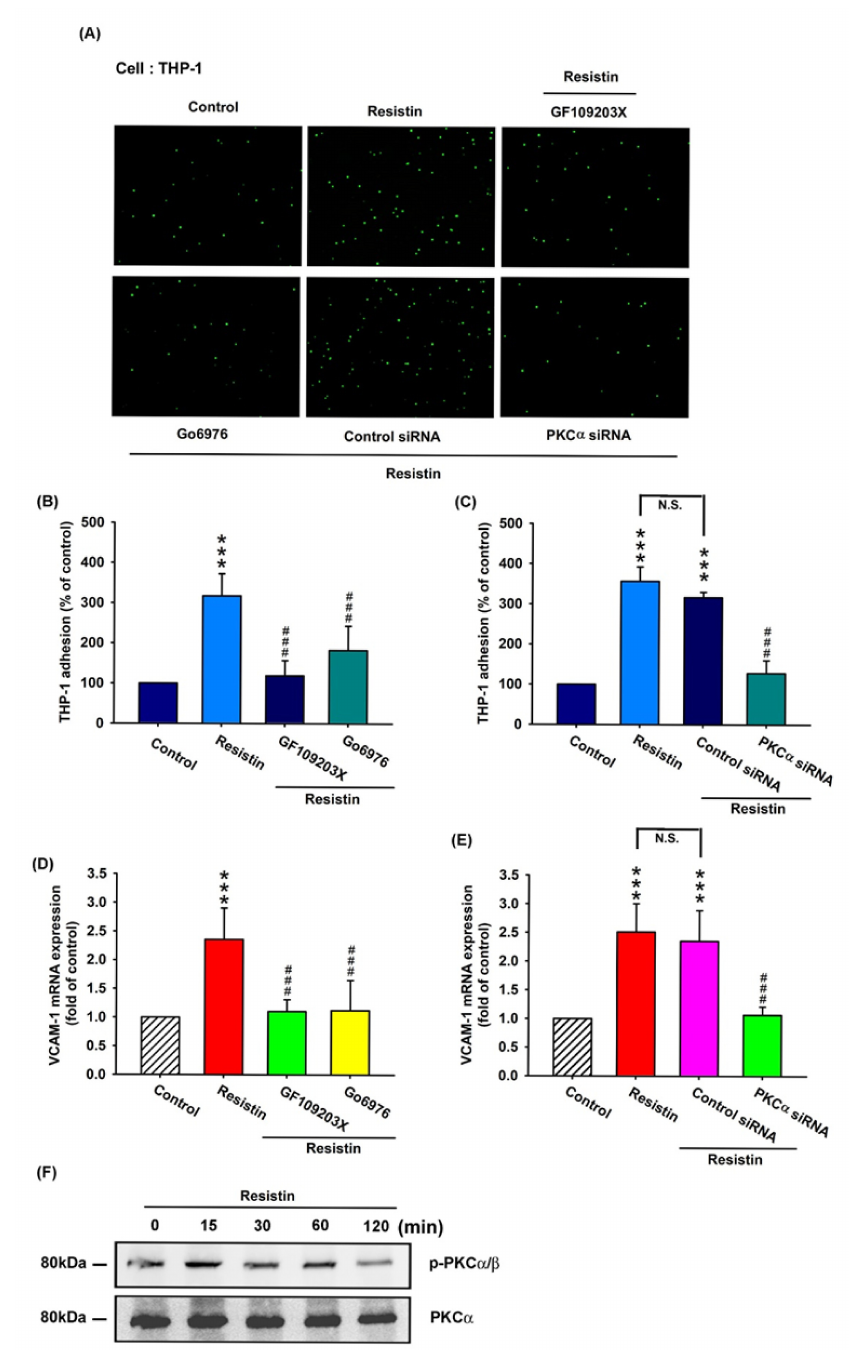
Figure 3. The PKC pathway is involved in resistin-enhanced VCAM-1 expression and monocyte adhesion. ( A – E ) OASFs were pretreated with a PKC inhibitor (GF109203x), a specific PKC α / β inhibitor (Gö6976), or a PKC α siRNA, then incubated with varying concentrations of resistin for 24 h. The adherence of THP-1 cells to cultured OASFs was photographed by fluorescence microscopy ( A ) and quantified (n = 4) ( B , C ). The transcription levels of VCAM-1 were quantified by the RT-qPCR assay (n = 4) ( D , E ). The extent of phosphorylation of PKC α / β under resistin (10 ng / mL) stimulation (for 0, 15, 30, 60, or 120 min) was quantified by Western blotting (n = 3) ( F ). *** p < 0.001 compared with control group; ### p < 0.001 compared with the resistin-treated